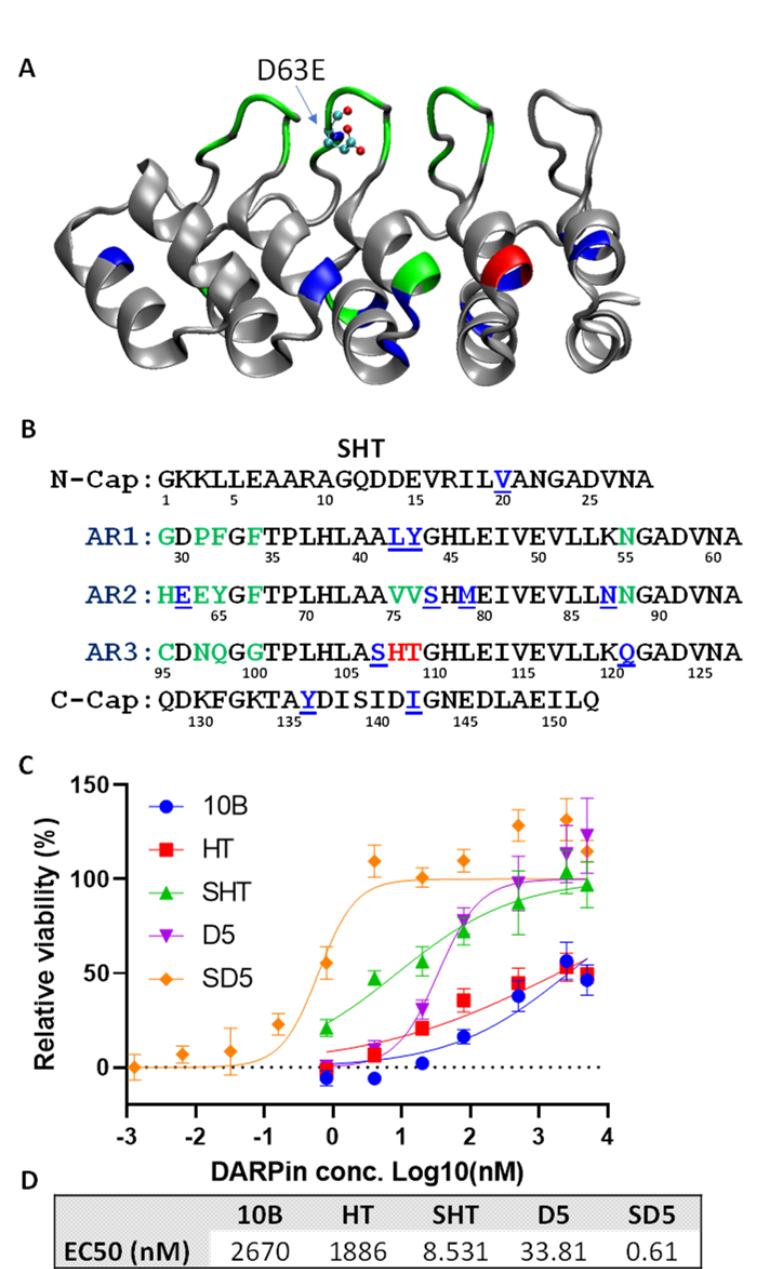
Figure 3. Homology model ( A ) and amino acid sequence ( B ) of DARPin SHT showing the derivation of key putative Stx2a-binding residues. The green, blue, and red residues are derived from the original DARPin library, error-prone PCR library, and saturation mutagenesis library. ( C ) Protection of Vero E6 cells by the different DARPins. Vero E6 cells (1.5 × 10 3 cells/well) were incubated with 5 pg/mL (57 fM) Stx2a and the appropriately diluted DARPin for 3 days. Error bars represent the standard deviation of two independent experiments performed in duplicate. ( D ) Summary of EC 50